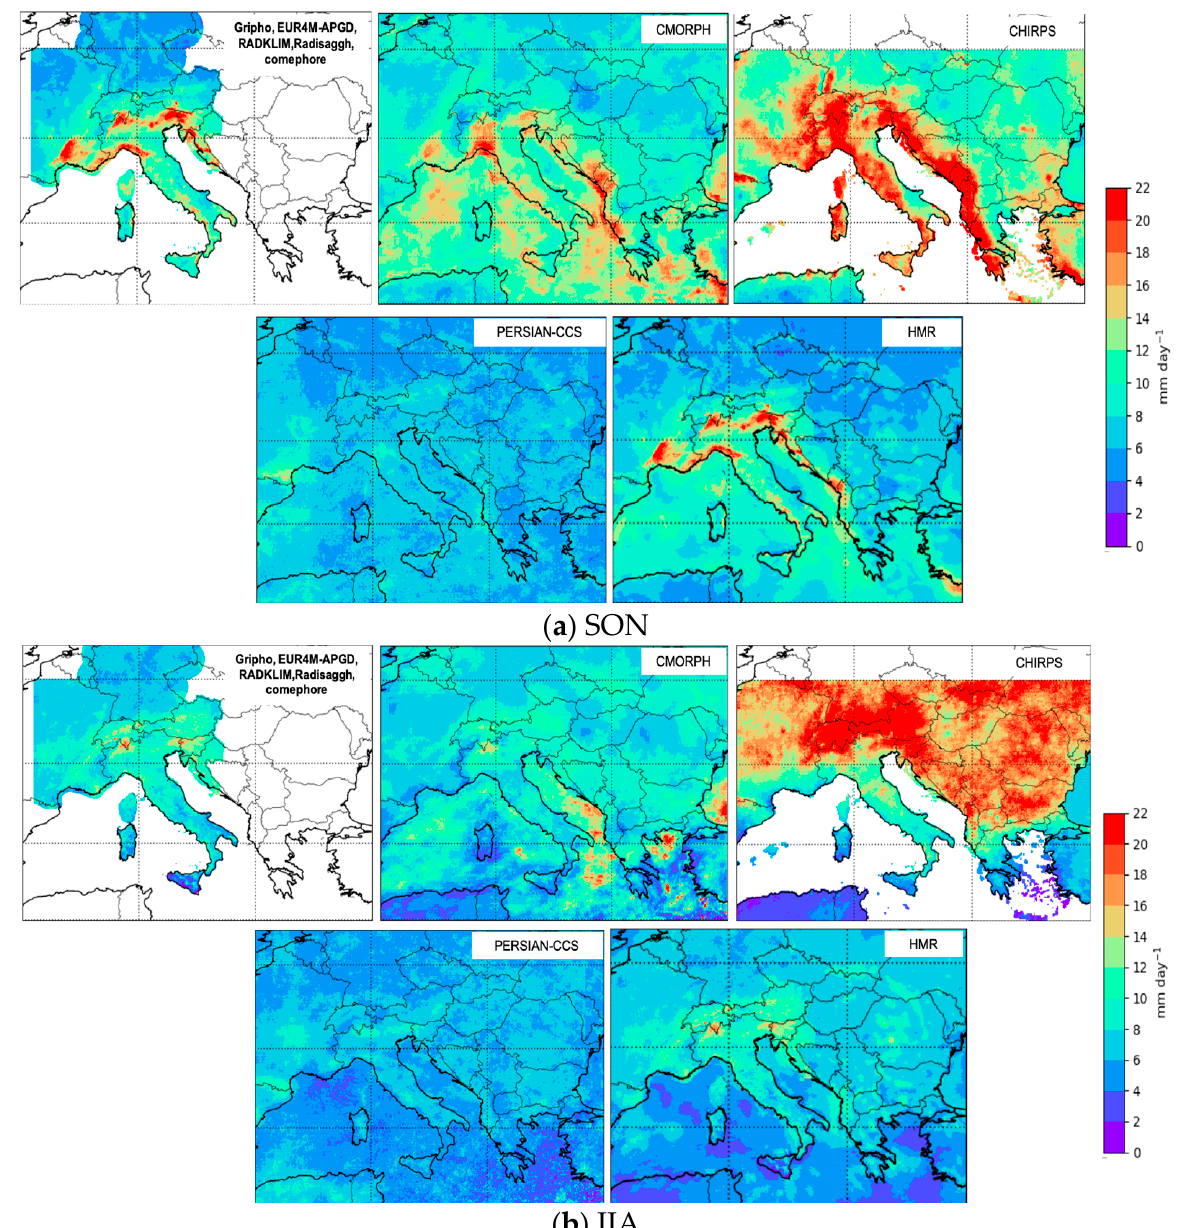
Figure 3. Seasonal mean daily precipitation calculated for different observational datasets described in Table 2 for autumn ( a ) and summer ( b ) seasons.